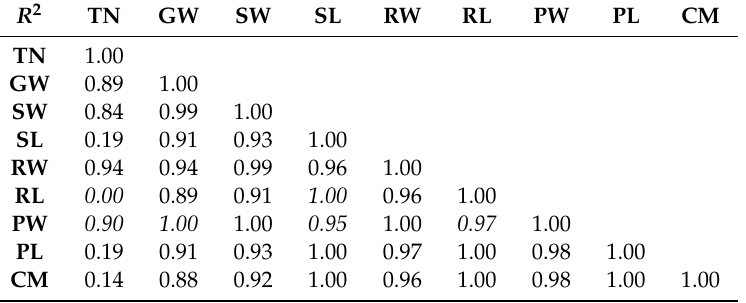
Table 1. A table of correlativity of yield component variables of NERICA-4 upland rice. In the table, TN = tiller number, GW = grain weight, SW = shoot weight, SL = shoot length, RW = root weight, RL = root length, PW = panicle weight, and PL = panicle length and CM crop moisture content. R 2 TN GW